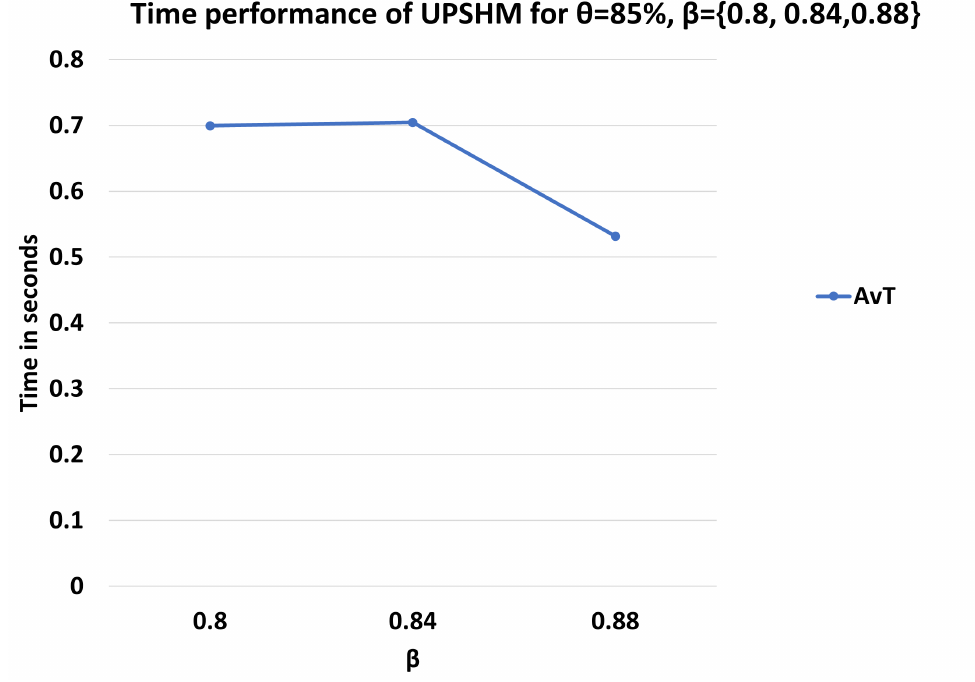
Figure 8. AvT of UPSHM for different values of β .